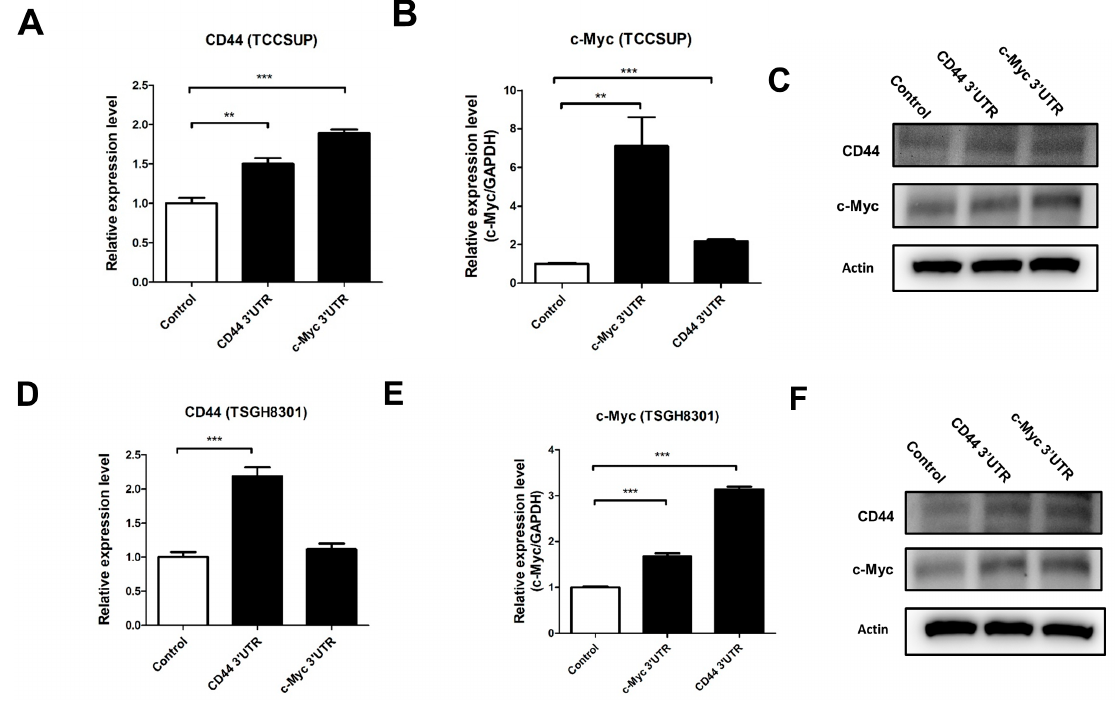
Figure 3. c-Myc acts as a ceRNA of CD44 in urothelial carcinoma cells. TCCSUP ( A – C ) or TSGH8301 ( D – F ) UC cells overexpressing the c-Myc 3 ′ UTR or CD44 3 ′ UTR. Expression of CD44 and c-Myc, as evaluated using RT-PCR (mRNA, A,B,D,E ), and eestern blot analysis (protein, C,F ). GAPDH was used as loading control for western blot analysis. (** p < 0.01, *** p < 0.001).